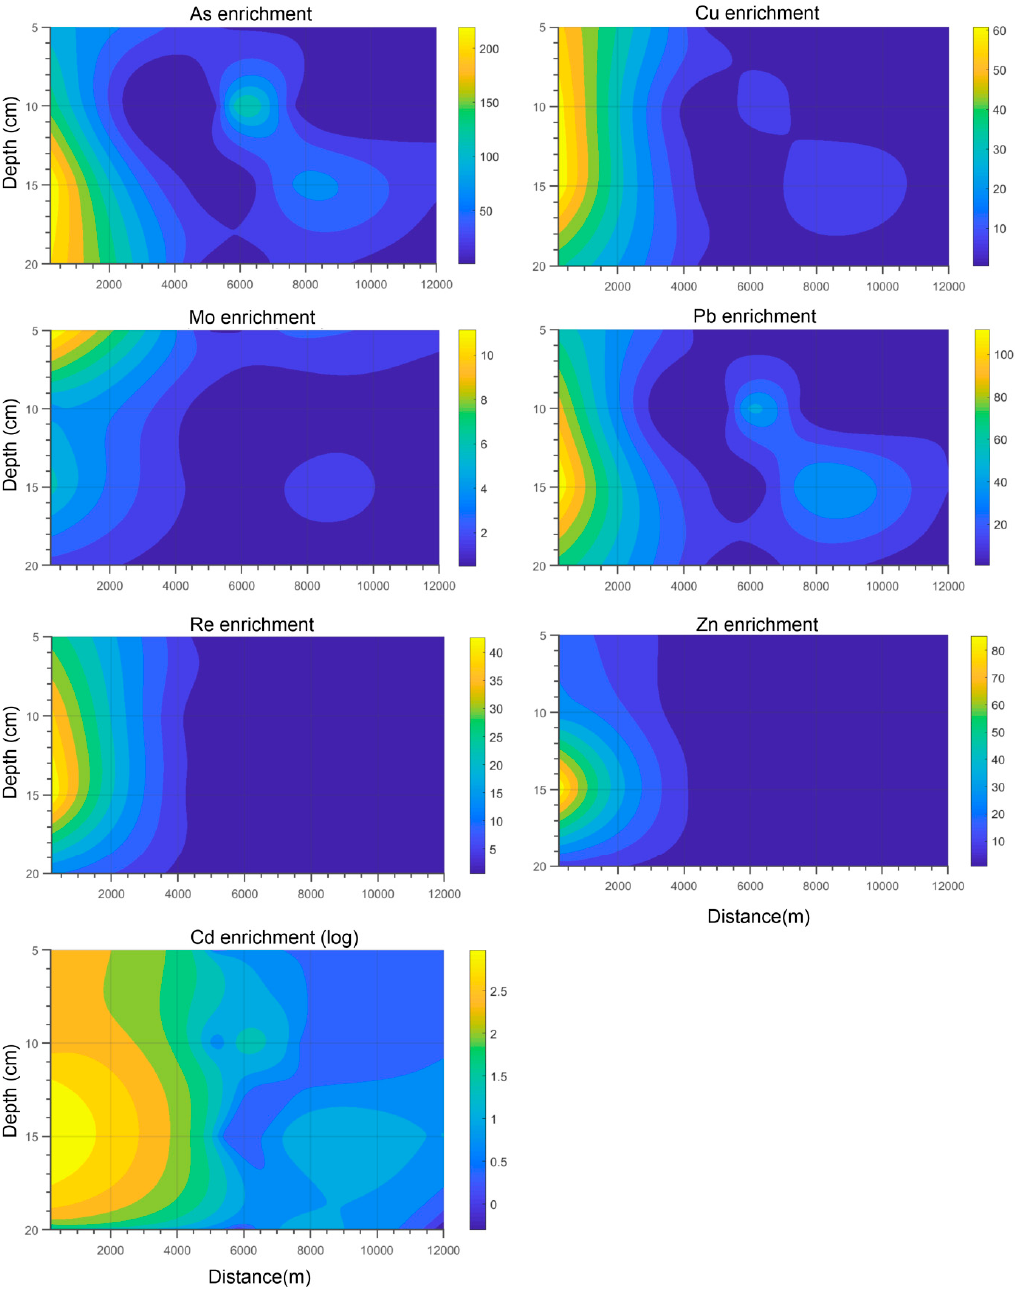
Figure 2. Enrichment factors for As, Cd, Cu, Mo, Pb, Re, and Zn using non-linear interpolation between the transect core samples (Figure 1). The enrichment factor (EF) is calculated as [Analyte] sample /[Analyte] deep core average , where “deep core average” is the average concentration in the section between 1.0–5.8 m in a 5.8 m deep core from the open Bothnian Bay [50]. A rather unexpected finding from the comparison of spatial distributions of several elements has to be mentioned. Rhenium is present in low concentrations in natural envi- riched in the core from Site A (Figure 1) with an EF of 14–47, while sediments collected further out in the transect had relatively stable concentrations close to the background. By